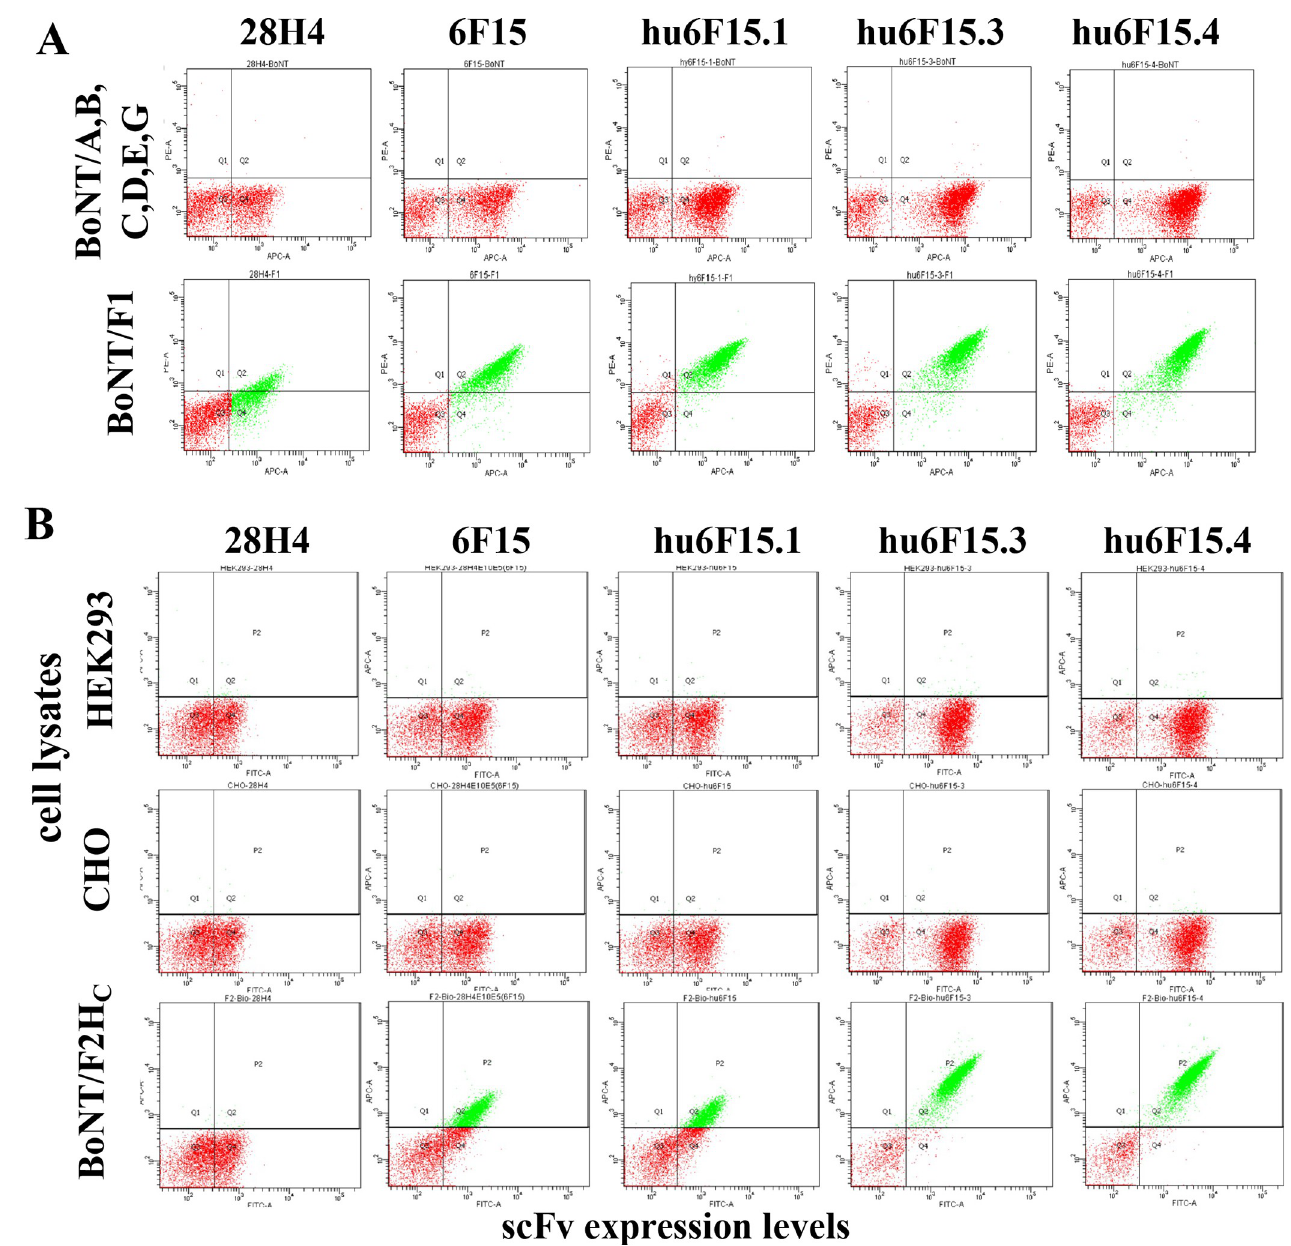
Fig 5. Specificity of mAbs with broadened specificity and improved affinity. A. Yeast displaying the indicated scFv were stained with either an equimolar mixture of BoNT serotypes A, B, C, D, E, and G or with BoNT/F1. Each yeast displayed scFv bound BoNT/F1 but did not bind the mixture of the other six serotypes. B. Yeast displaying the indicated scFv with stained with either biotinylated HEK293 or Chinese Hamster Ovary (CHO) cell lines or with biotinylated BoNT/F2H C as a positive control. Binding was detected using streptavidin-PE. scFv did not bind HEK or CHO cell lines but did bind BoNT/F2 in proportion to their